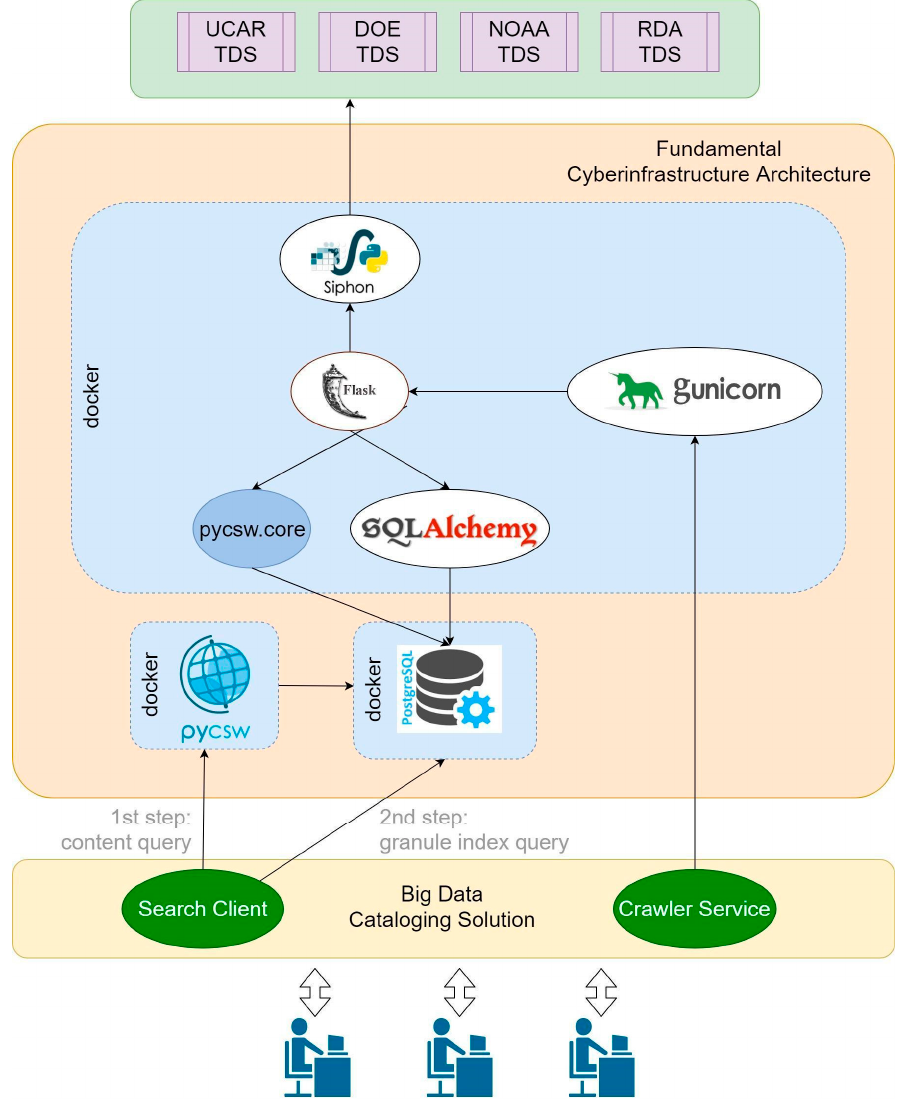
Figure 8. Implementation architecture for searching big data served via Unidata THREDDS Data Server (TDS). Although in our study only UCAR TDS is used, the system is designed to support any TDS repository as a data